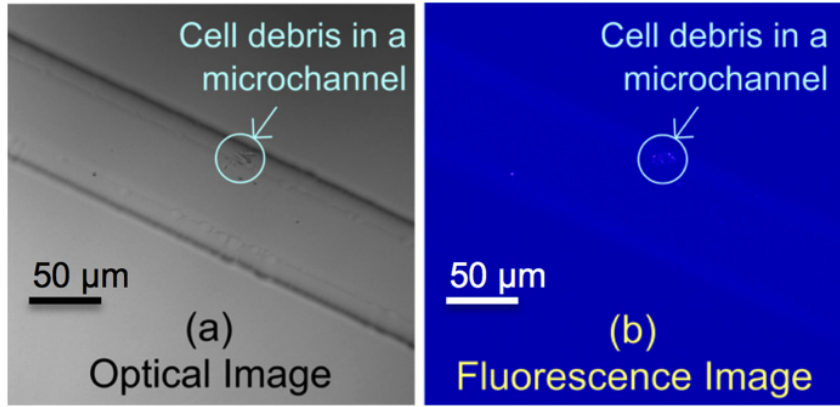
Figure 4. Cell debris, labeled with Alexa Flour 488 V florescence dye, collected from a fingerprint sample, is positioned inside a microchannel and is observed under a fluorescence microscope. ( a ) Image of the cell with optical microscope with phase-contrast mode; ( b ) image of the cell with 488 nm laser in a fluorescence microscope.